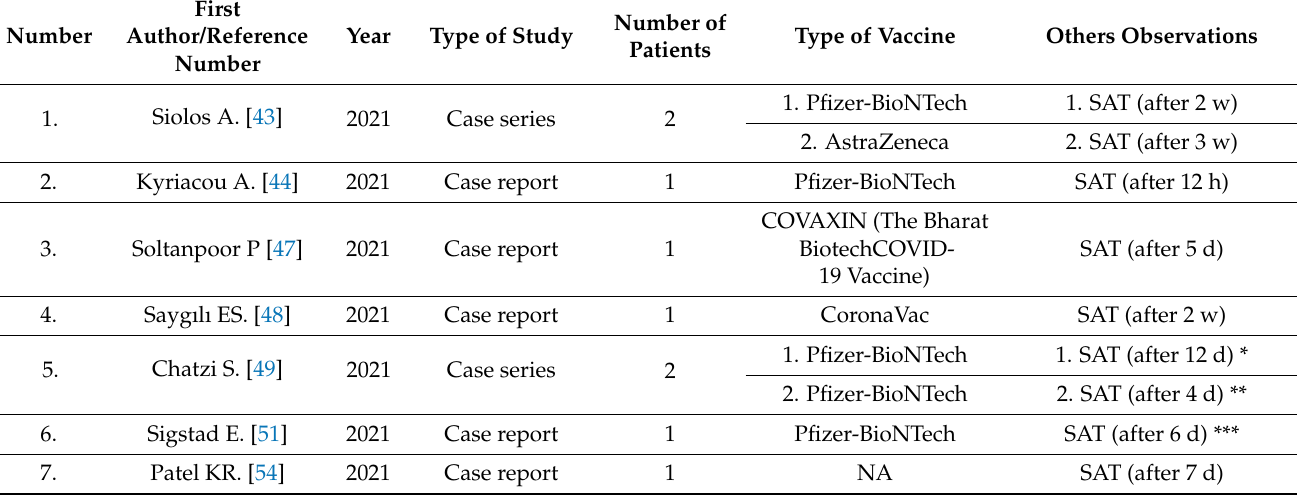
Table 2. Evidence of subacute thyroiditis following vaccination against COVID-19 infection (the name of the vaccine as used by authors of the original studies is